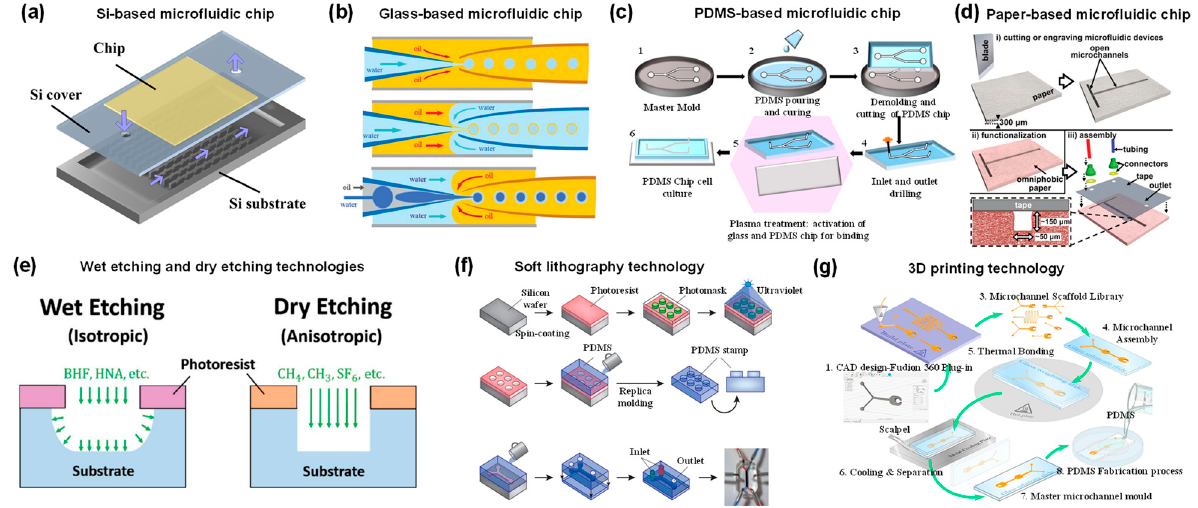
Figure 1. ( a ) Schematic diagram of silicon-based microfluidic device. Reproduced with